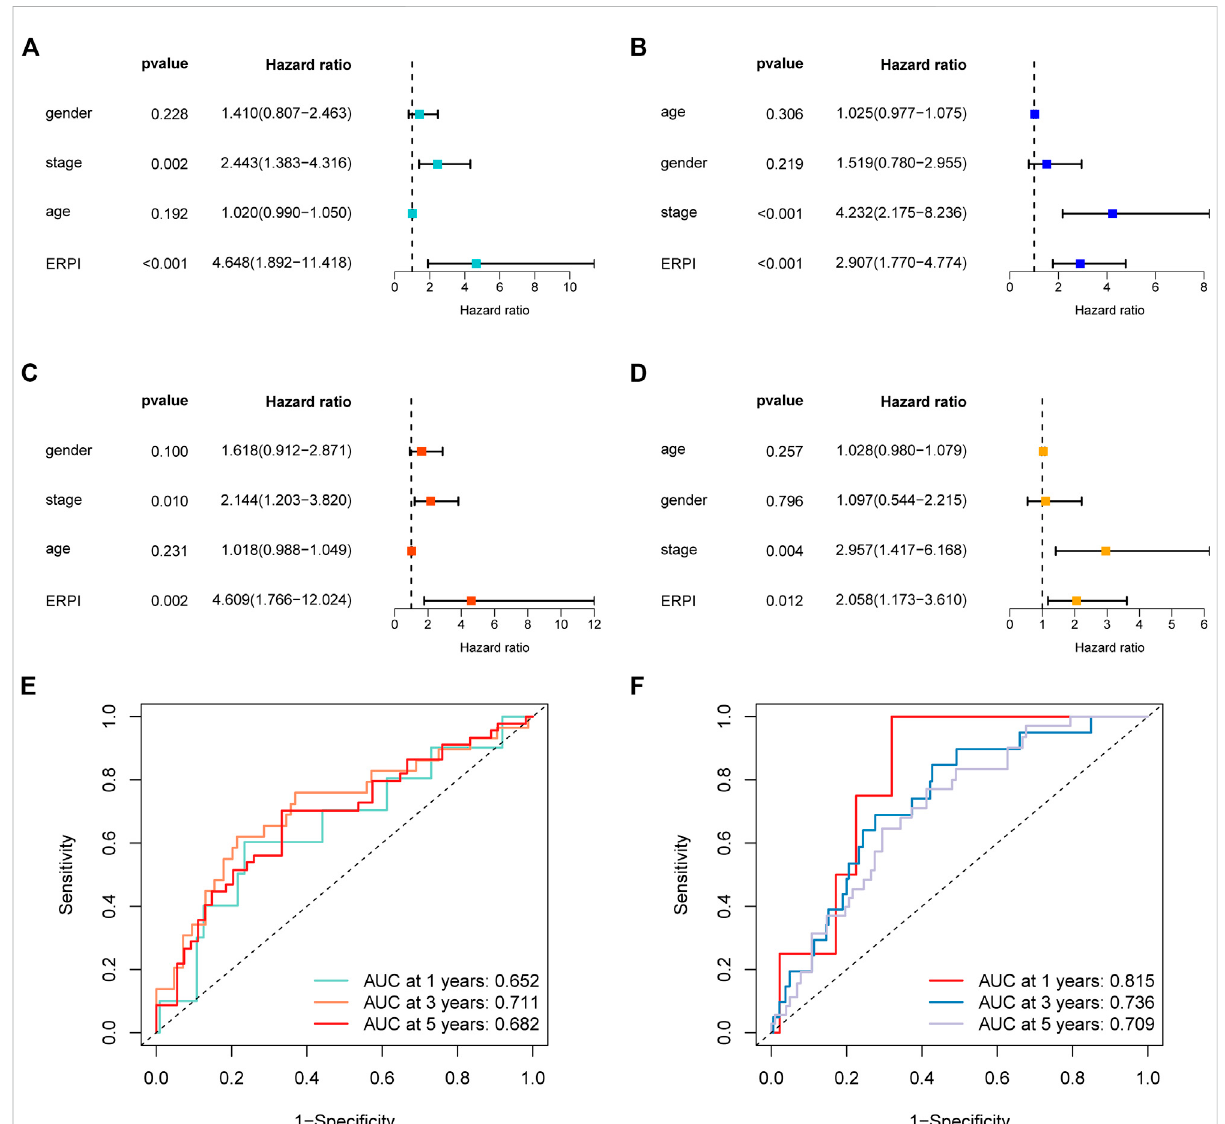
FIGURE 4 Validation of ERPI in GSE50081 and GSE31210. (A) Effect of ERPI and clinicopathological parameters on survival in univariate Cox regression analysisinGSE50081. (B) EffectofERPIandclinicopathologicalparametersonsurvivalinunivariateCoxregressionanalysisinGSE31210. (C) Effectof ERPI and clinicopathological parameters on survival in multivariate Cox regression analysis in GSE50081. (D) Effect of ERPI and clinicopathological parameters on survival in multivariate Cox regression analysis in GSE31210. (E) Time-dependent ROC curves of ERPI in GSE50081. (F) Time- dependent ROC curves of ERPI in